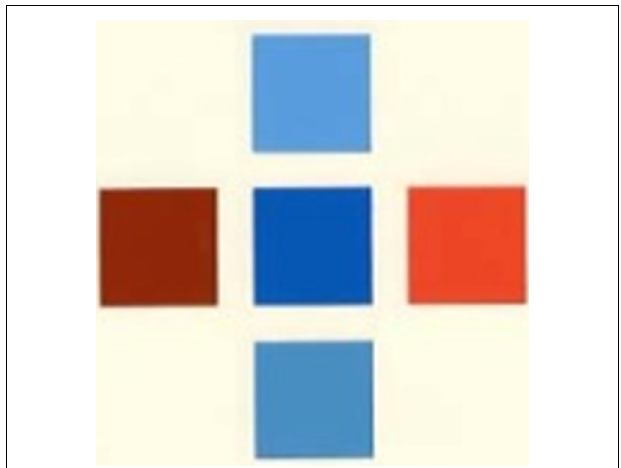
FIGURE 1 | Example of the Color MateTest (Kaneko, 1995). Participants were asked which line is a similar color: vertical or horizontal. In the case shown, vertical line consists of three blue colors. (http://nodaiweb. university.jp/cms/)